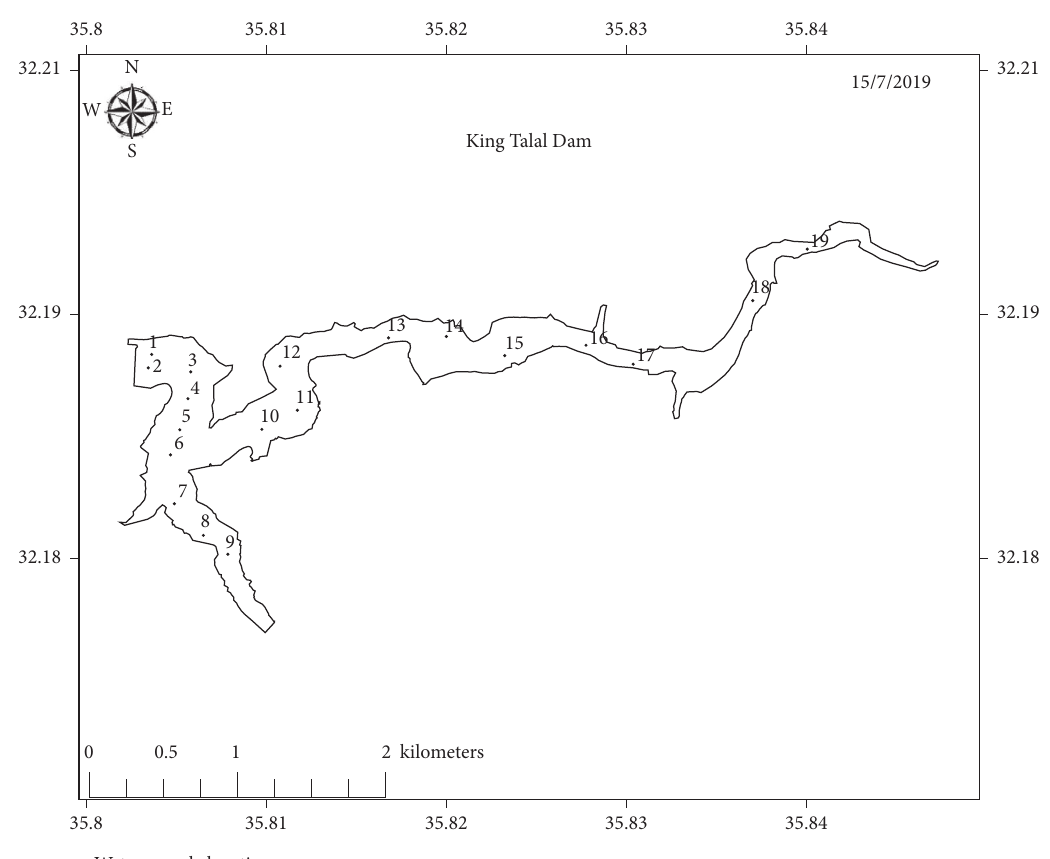
Figure 2: Sampling points distribution of King Talal